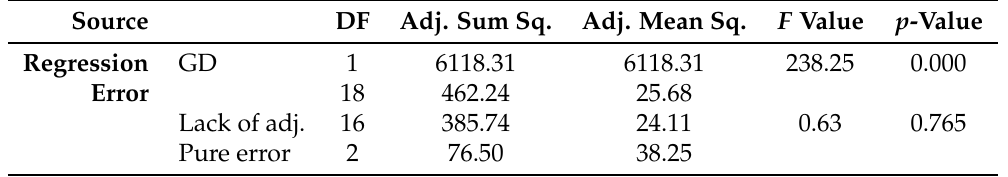
Table 1. Analysis of variance.